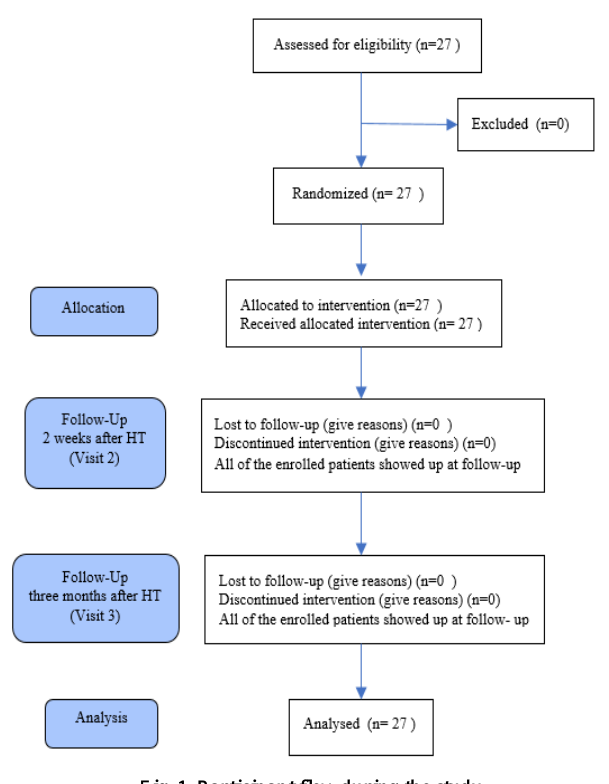
Fig. 1. Participant flow during the